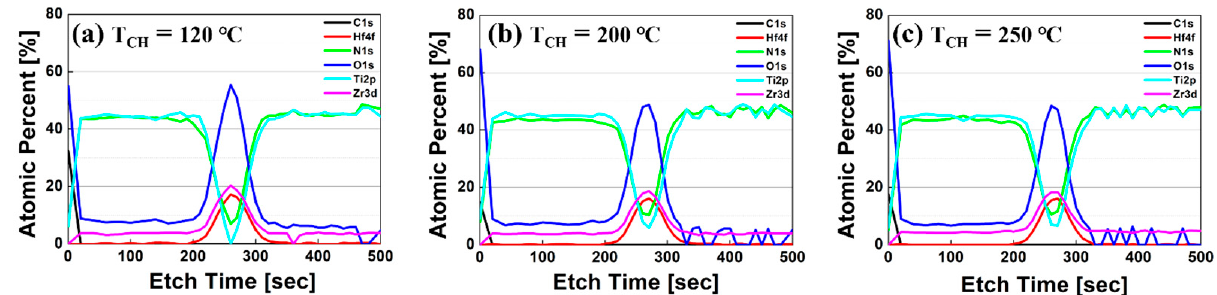
Figure 3. Measured XPS depth profiles of TiN (50 nm)/HZO (10 nm)/TiN (50nm) capacitor, which was fabricated at three different chamber temperatures: ( a ) 120 °C, ( b ) 200 °C, and ( c ) 250 °C.